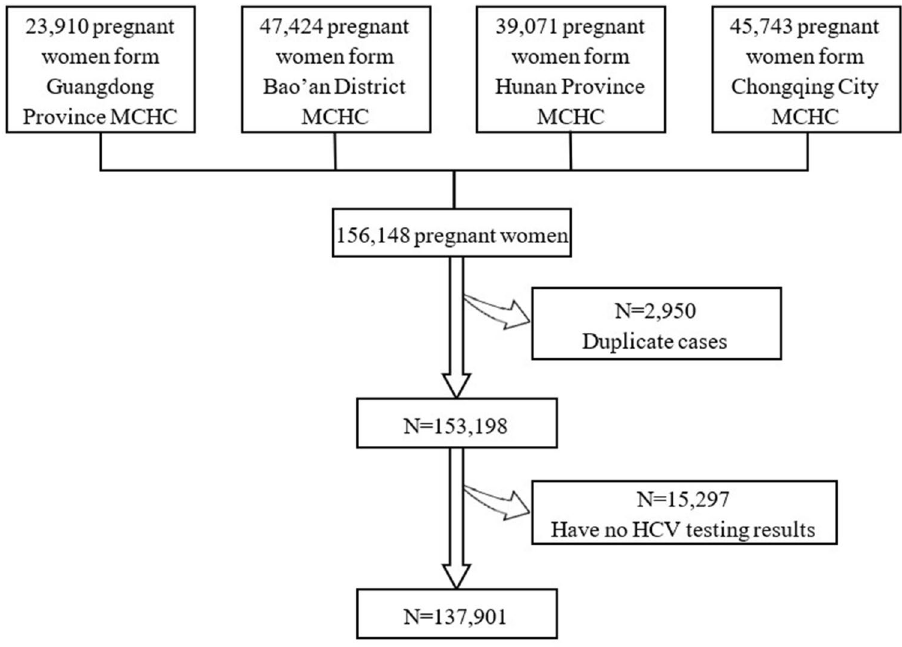
Figure 1. Flowchart of study